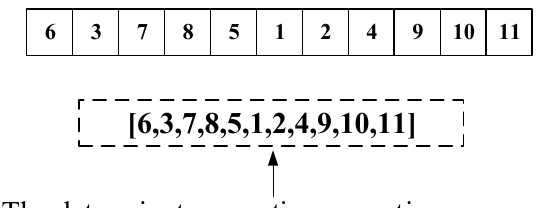
Figure 7. Example of encoding and decoding.